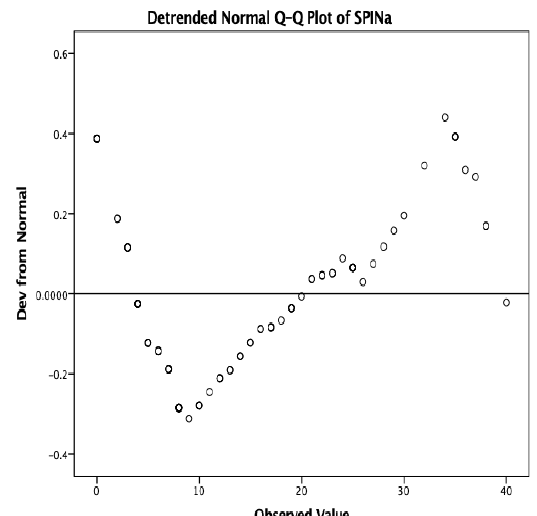
Figure 4. Distribution of the scores obtained in the SPIN (SPINa — initial evaluation).